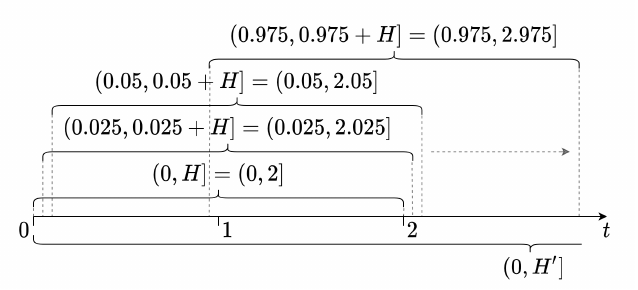
Figure 4. Moving prediction horizon of finite dimensional representation.